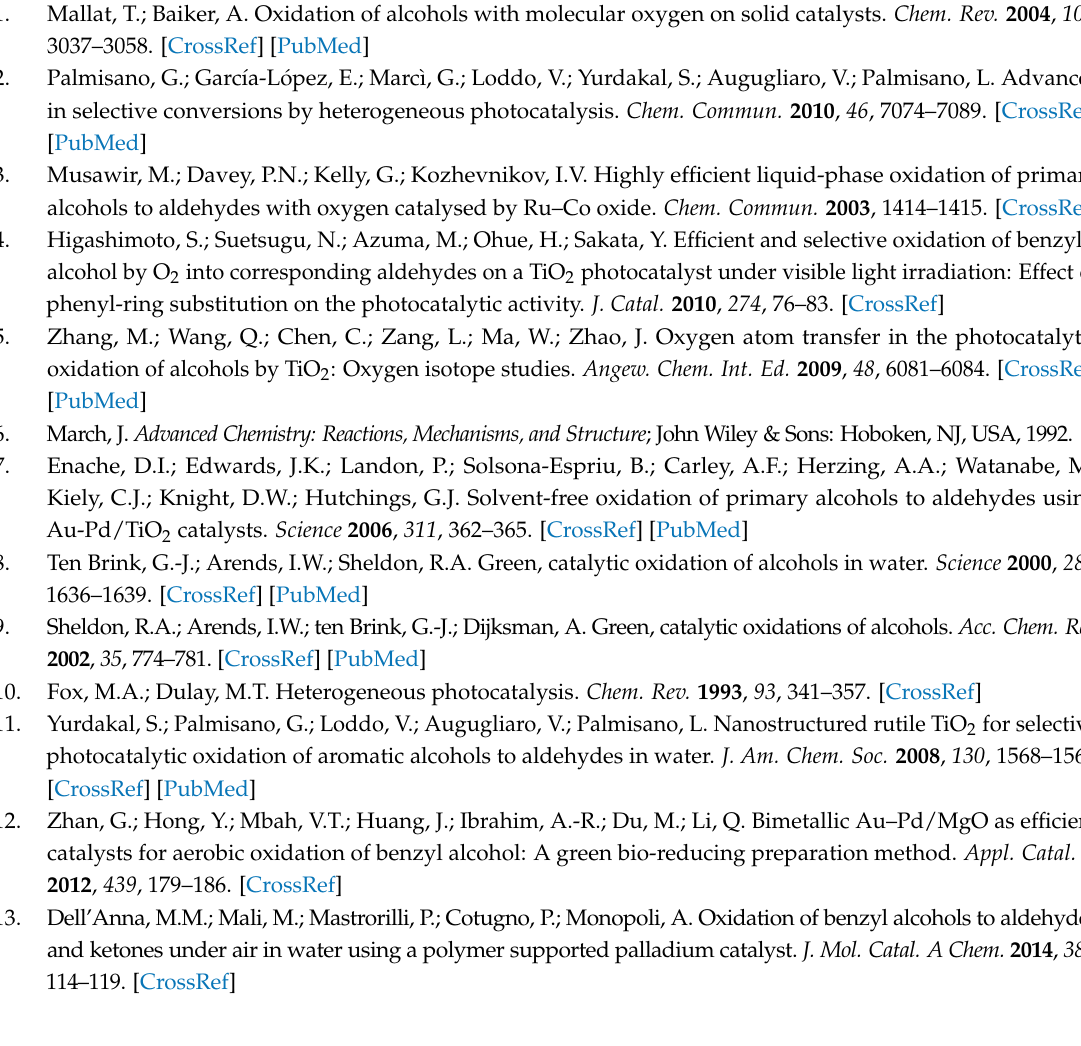
Figure S1: XRD patterns of ZnO x (1%)–MnCO 3 /(1%)HRG catalyst (a) fresh and (b) recycled, Figure S2: TGA isothermal pattern of ZnO x (1%)–MnCO 3 /(1%)HRG